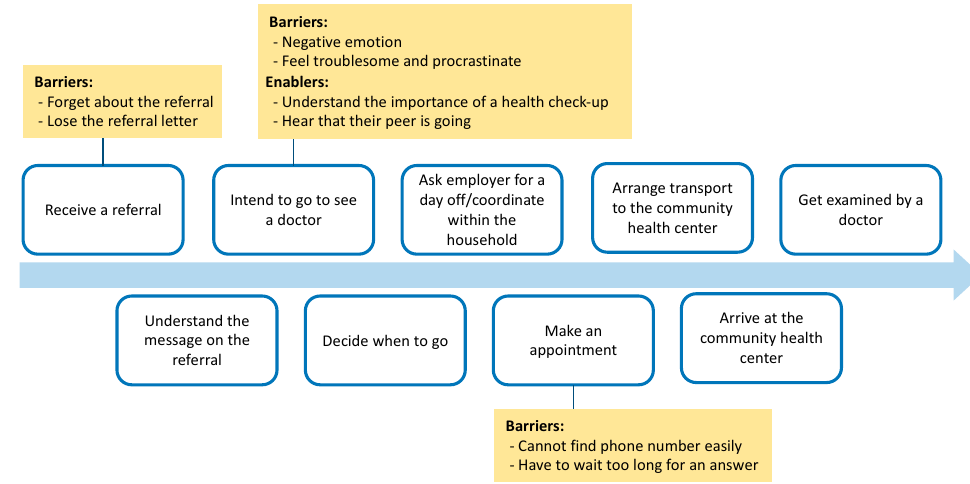
Figure 4. Behavioral process map and barriers/enablers: Example to increase attendance at the community health center following a medical referral based on screening. Note. There are likely more barriers and enablers for each step, but only the major elements are shown in the figure.